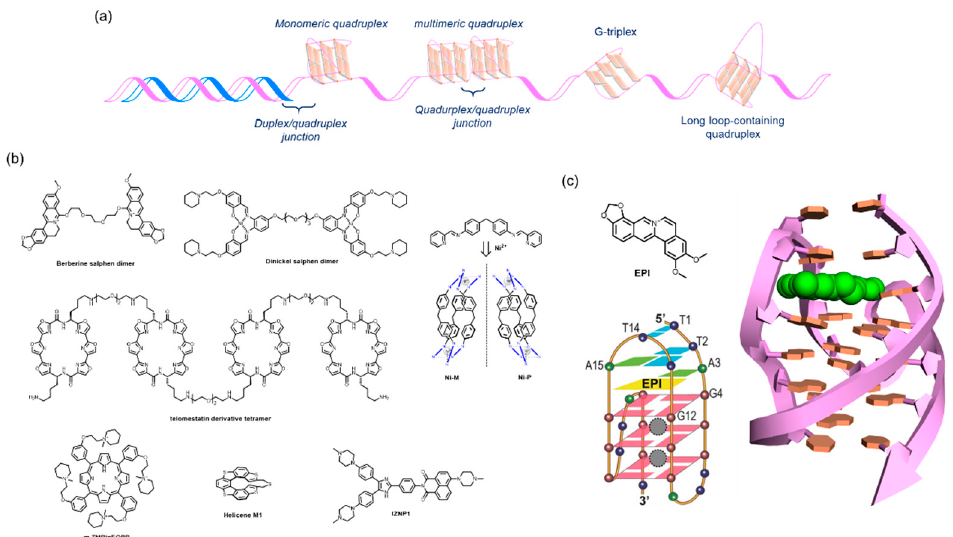
Figure 2. Selective telomere G4 targeting by ligands. ( a ) Telomere G-stretch sequences potentially adopt non-canonical G4s that offer specific binding motifs. ( b ) Several telomere G4-preferred binders based on the specific-motif recognition. It is worth noting that the by Ni-M and IZNP1 exhibit differential antitumor activities, likely based on the specific-motif recognition of telomere G4s. ( c ) EPI and the solution structure of the EPI-wtTel26 complex (PDB code: 6ccw). The bases that do not participate in the interaction event with EPI are omitted for clarity. Figure 2a,c were adapted with permission from References 56 and 86, respectively.